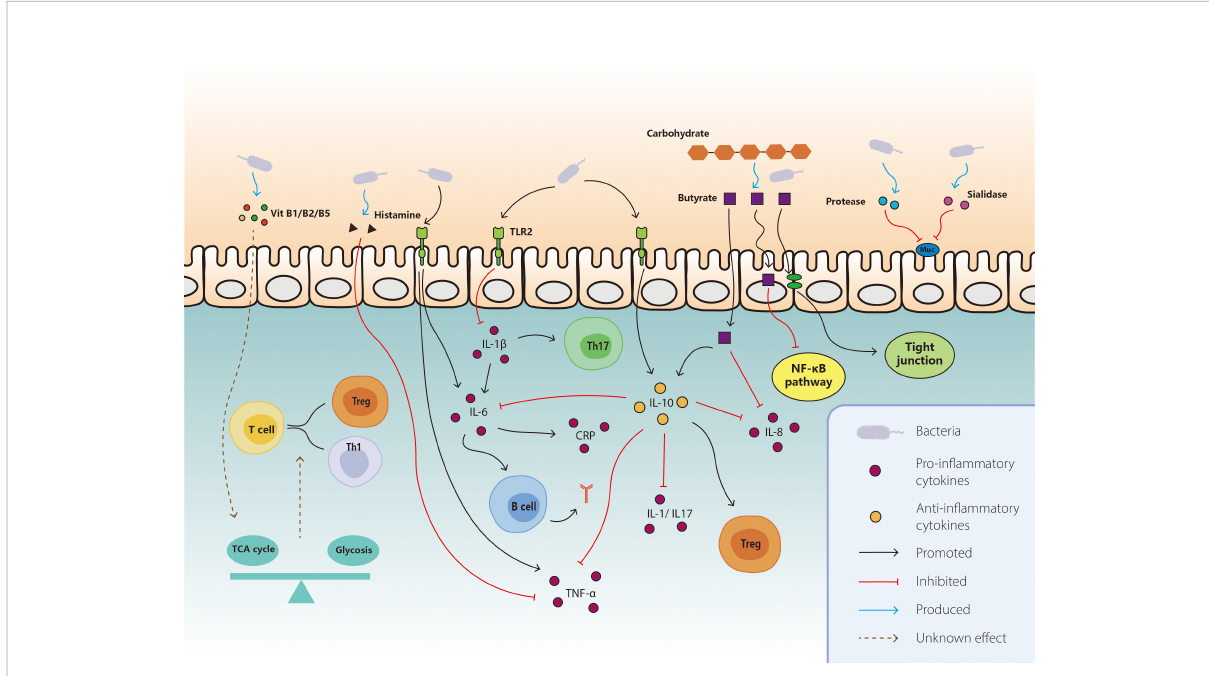
FIGURE 1 Mechanisms of interaction between gut microbiota and ICI-related colitis. On the basis of the known interaction between gut microbiota and IRC, the main mechanisms included direct effect, metabolites, cytokines, and immune cells. For protective bacteria, the pro-in fl ammatory pathways like IL-1b and TNF-a are inhibited, together with promoted anti-in fl ammatory pathways including IL-10, Th17 cells, and Treg cells. They also modulate the differentiation of T cells through vitamin B and tricarboxylic acid cycle. Butyrate produced by bacteria exerts anti- in fl ammatory effect via various aspect like consolidating tight junction, inducing IL-10 and suppressing NF- k B. As for harmful bacteria, they secrete some enzymes to destruct mucin and enhance the pro-in fl ammatory pathway like IL-6, TNF-a, CRP, and antigen production. TCA, tricarboxylic acid; NF-kB, nuclear factor kappa B; TLR, toll-like receptor; TNF-a, tumor necrosis factor-a; IL, interleukin; CRP, C-reactive